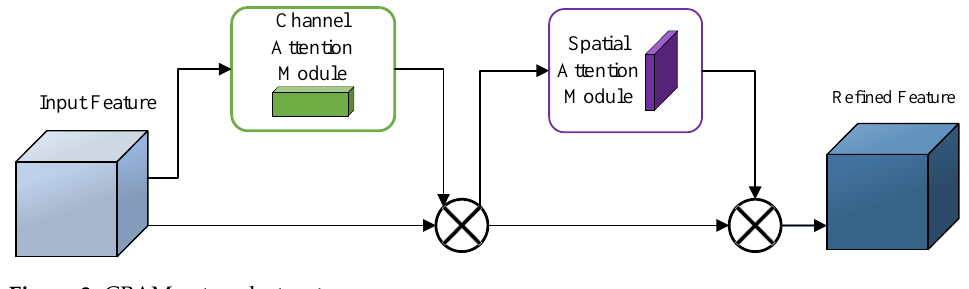
Figure 3. CBAM network structure.